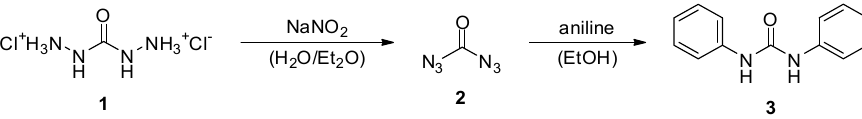
Scheme 1. Synthesis of carbonyl diazide ( 2 ) from carbonyl dihydrazide dihydrochloride ( 1 ) and transformation to diphenylurea ( 3 ).